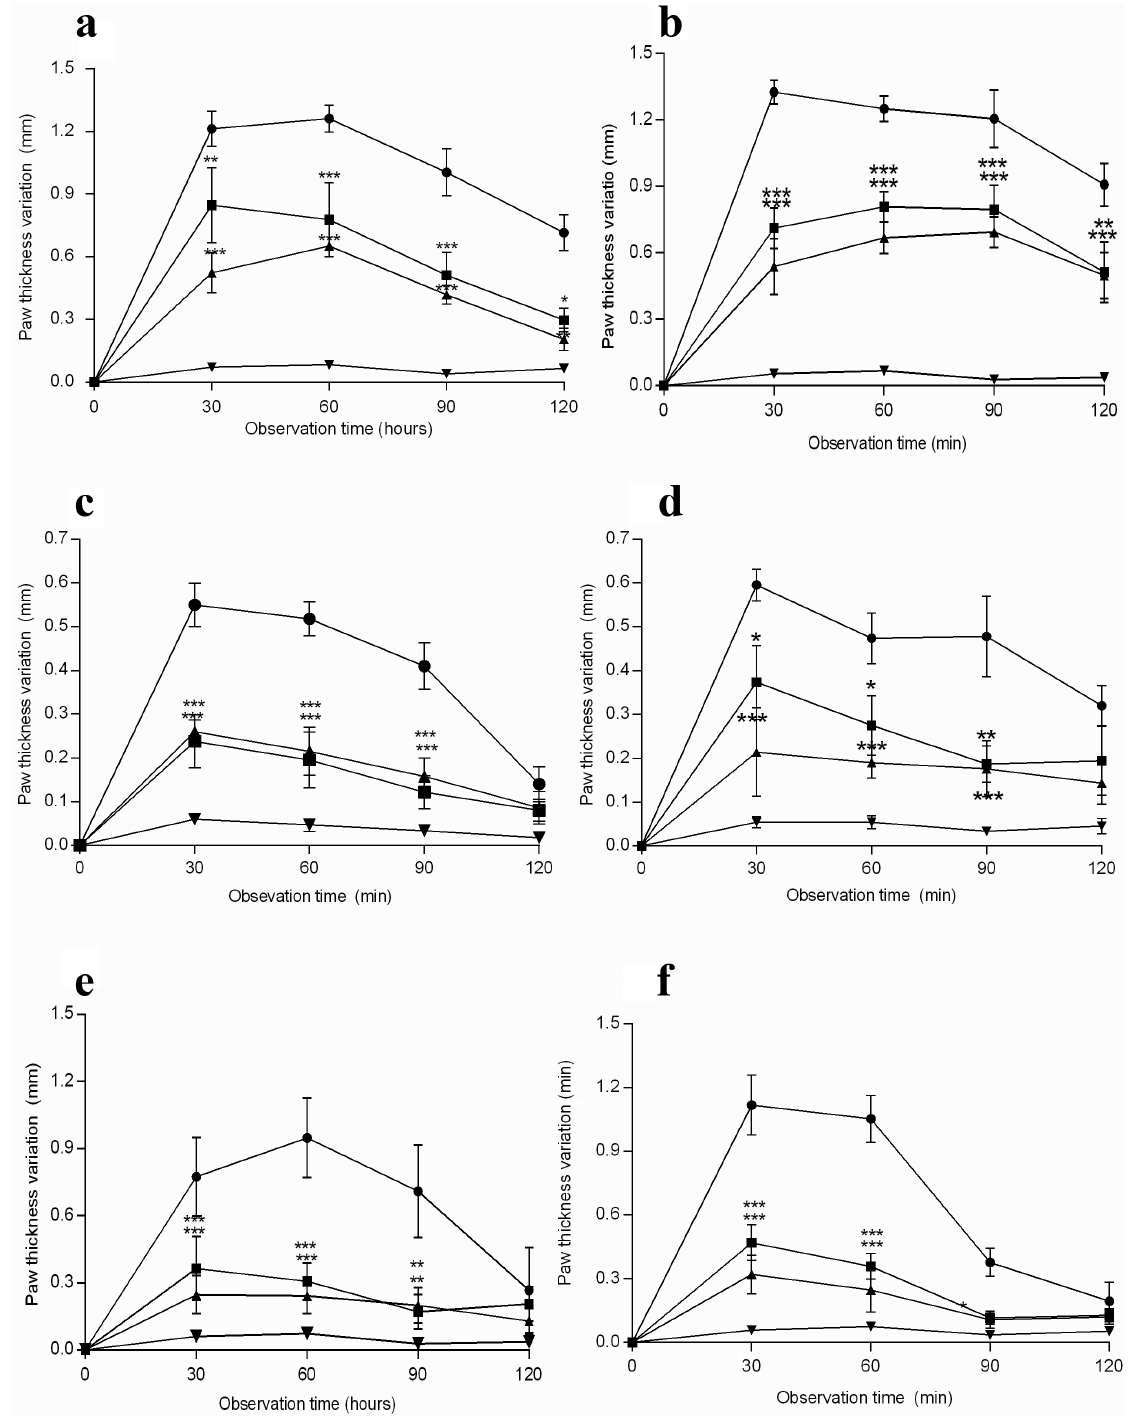
Figure 3 - Effect of the NST (●) , vehicle (■) and indomethacin (▲) on paw edema induced by different phlogistic agents (1.0%; 0.1 mL, i.pl.) in mice, as follows: Dextran (a) ; Compound 48/80 (b) ; Histamine (c) ; Serotonin (d) ; Capsaicin (e) ; and Prostaglandin E2 (f) . The sham group (▼) was treated with vehicle and received only saline by intraplantar route. The values are expressed as mean ± SEM. * p <0.05, ** p <0.01 and *** p <0.001 when compared with vehicle group. Two - way ANOVA followed by Bonferroni’s post-hoc